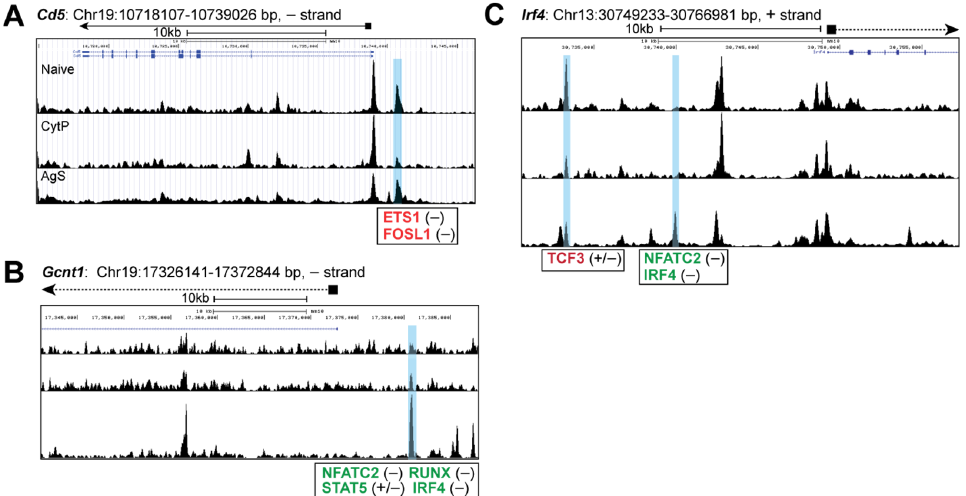
Figure 6. Chromatin accessibility of genes coding for proteins known to be modulated by cytokines in CD8 + T cells. Genome browser snapshots of chromatin accessibility signals near genes coding for proteins modulated by cytokine priming (( A ), Cd5 ), Ag stimulation that promotes migration potential of memory CD8 + T cells (( B ), Gcnt1 ), and the strength of pMHC-TCR interaction (( C ), Irf4 ) in CytP and AgS cells.